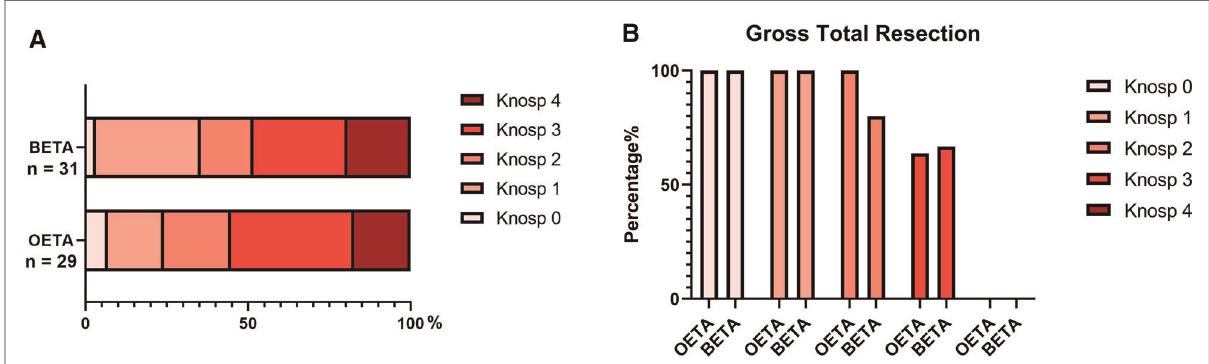
FIGURE 3 The tumor removal of the patients. ( A ) The constituent of patients with different Knosp grades in the two groups. ( B ) The gross total resection rate of tumors with different Konsp scores. binostril endoscopic transsphenoidal approach, BETA; one-and-a-half nostril endoscopic transsphenoidal approach,